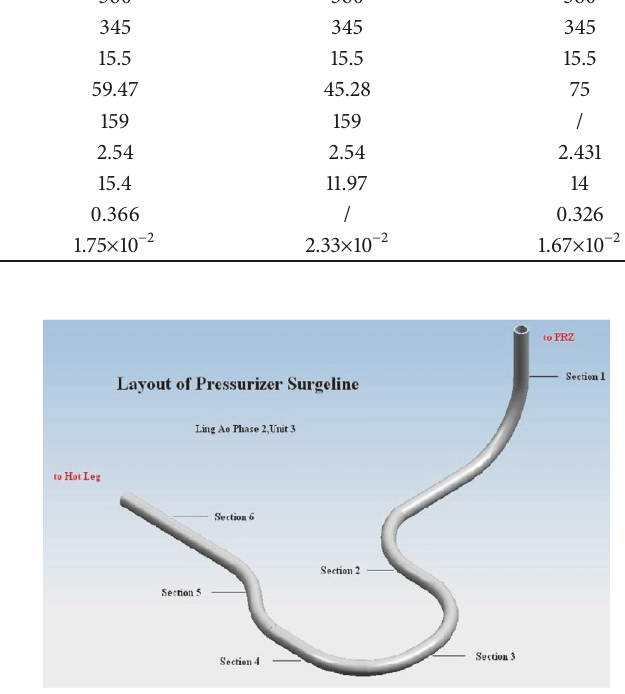
Figure 1: Surge line preinstallation